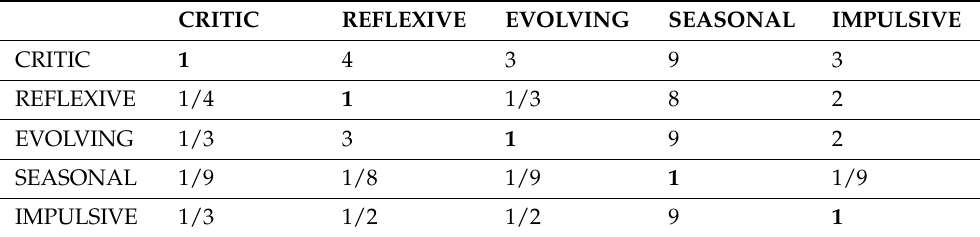
Table 3. Pairwise matrix H comparing the five product dimensions.